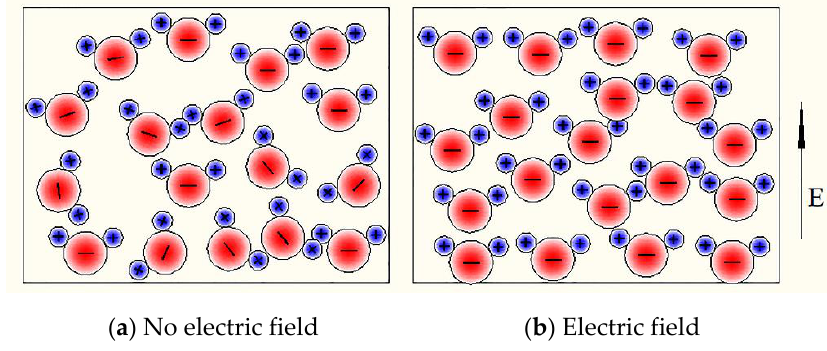
Figure 1. Diagram showing dielectric polarization.